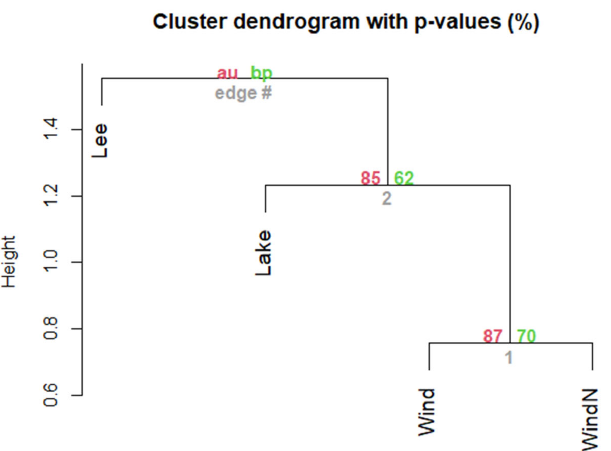
Figure 7. Hierarchical clustering analysis based on species composition at the four sites. The p -value (au) was given by 1000 bootstrap resampling. The final CCA model suggested that the first and second axis of environmental variables together explained 60% (33.8% and 26.6%, respectively) of the variation in epiphyte community composition (Figure 8). The constraining variables in the final model were site, host ‐ tree species, moss cover, host ‐ tree height, DBH, and branch height ( p < 0.001 with 999 permutation tests). There were 14 epiphytes that only occurred in one site (red color circles). The variables yellow cypress and moss cover distributed to the far ‐ left side of the first CCA axis, with six epiphytic species that only occurred in the Lake site. The variables Lee site, red cypress, host ‐ tree DBH, height, and branch height (BrH) were located on the right side of the first CCA axis, with seven epiphytic species that only occurred in the Lee site. The variable WindN site was on the upper part of the second CCA axis, and an epiphytic species that only occurred at the WindN site was also at the top of the triplot graph.